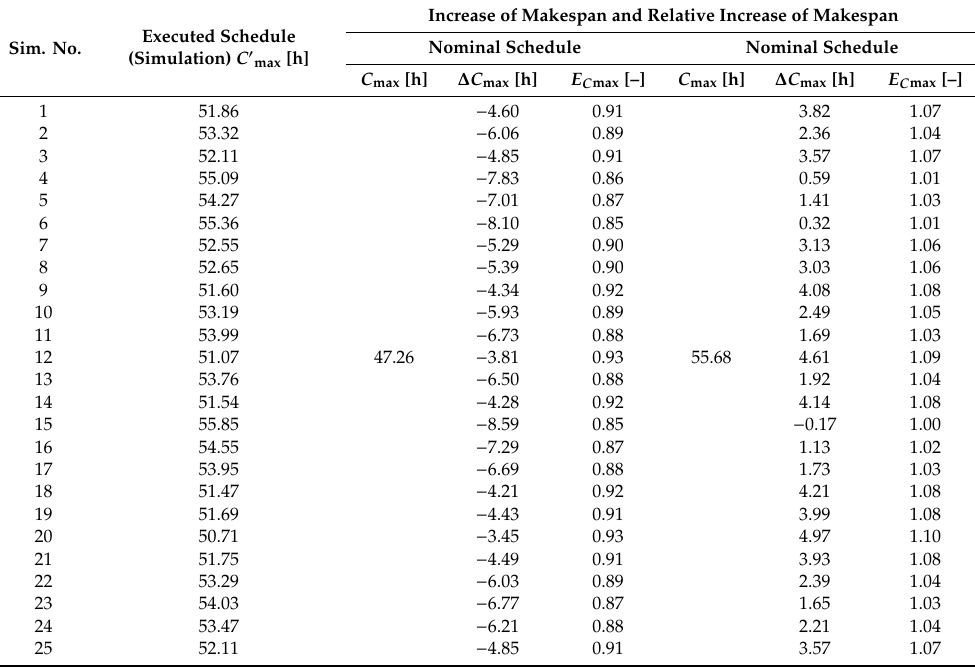
Table 10. Results from simulation: nominal and robust schedules (SPT).